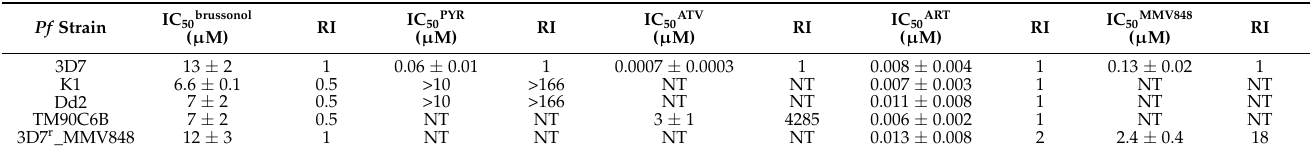
Table 2. IC 50 values of compound brussonol against a panel of sensitive and resistant P. falciparum strains.